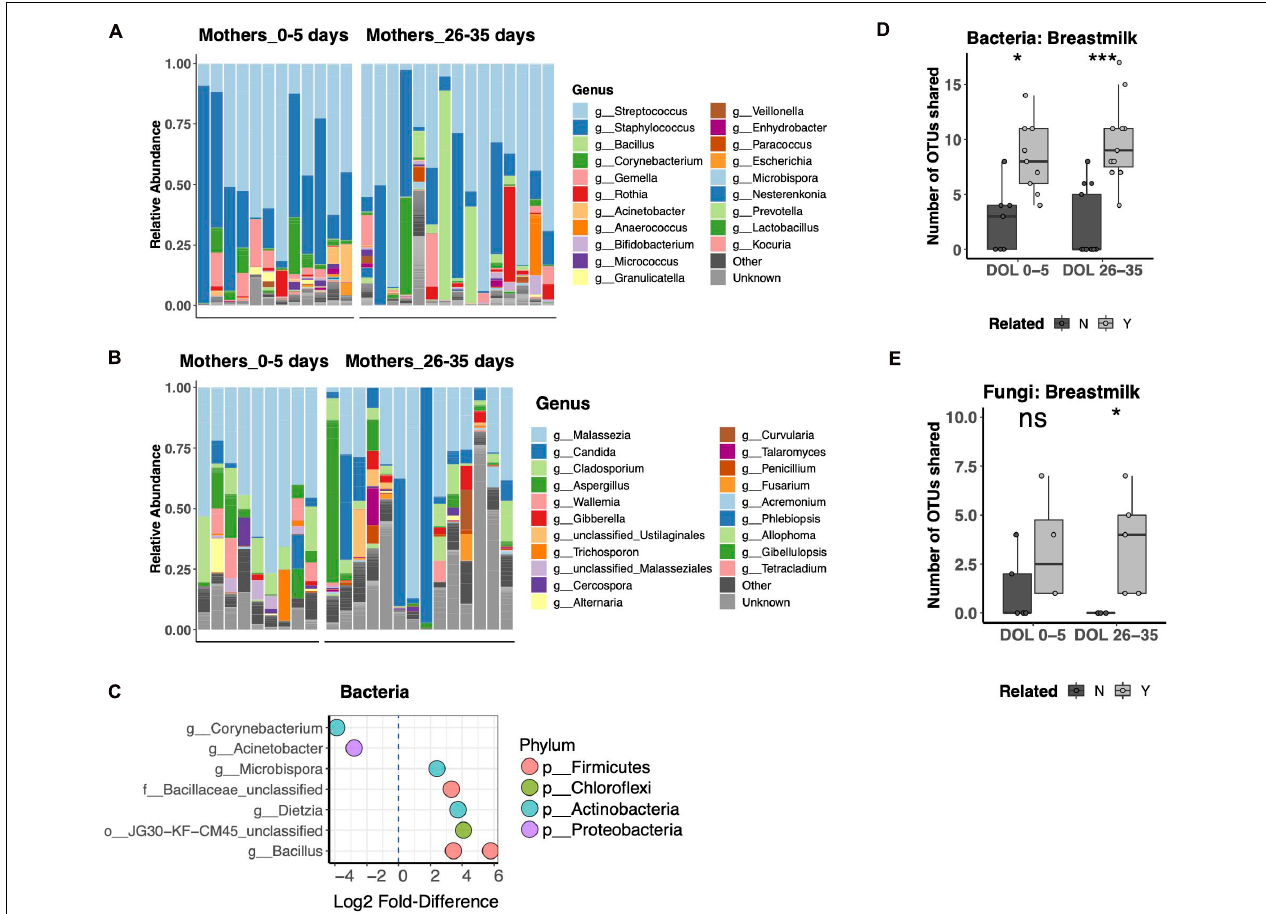
FIGURE 5 | Breast milk bacterial and fungal community composition. (A,B) Top 25 most abundant bacterial (A) and fungal (B) genera across all samples reveal that both communities are dominated by common skin taxa but also contain a diverse repertoire of microbes at lower abundances. (C) Differentially abundant taxa between mothers in the first compared to the fourth postpartum week. (D,E) Number of shared bacterial (D) and fungal (E) operational taxonomic units (OTUs) between mother–infant pairs in the first and fourth postpartum weeks. Statistics: *** p < 0.001, * p < 0.05, Wilcoxon rank-sum test, adjusted using the Bonferroni